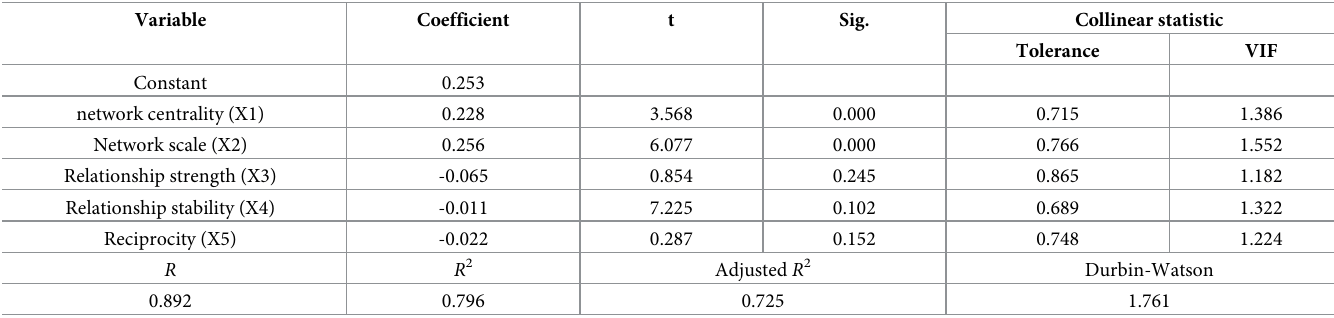
Table 12. Classified regression analysis results of network characteristics and organizational knowledge transfer performance.